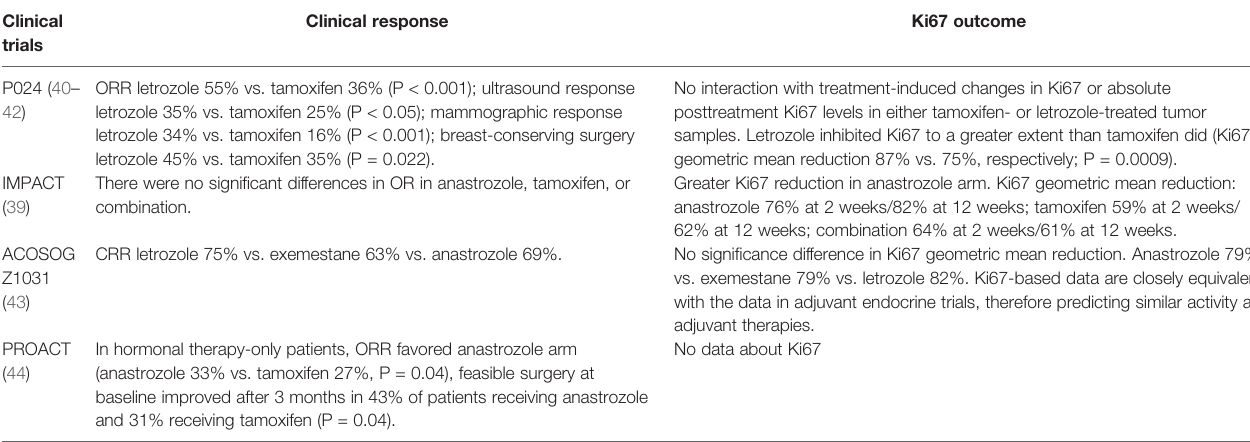
TABLE 1 | Main neoadjuvant endocrine